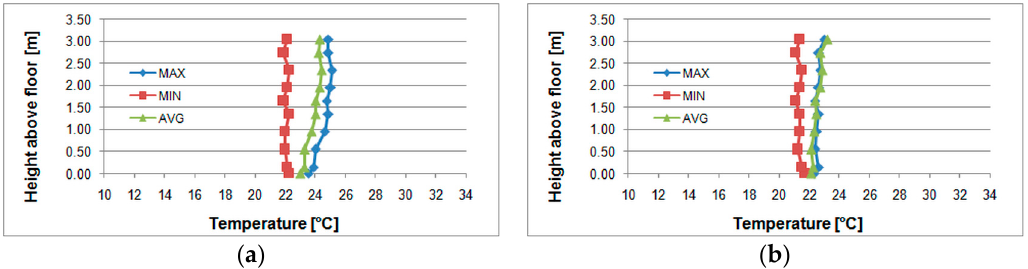
Figure 13. Vertical profile of the internal air temperature for the working hours: ( a ) during the hottest week; ( b ) during the coldest week.